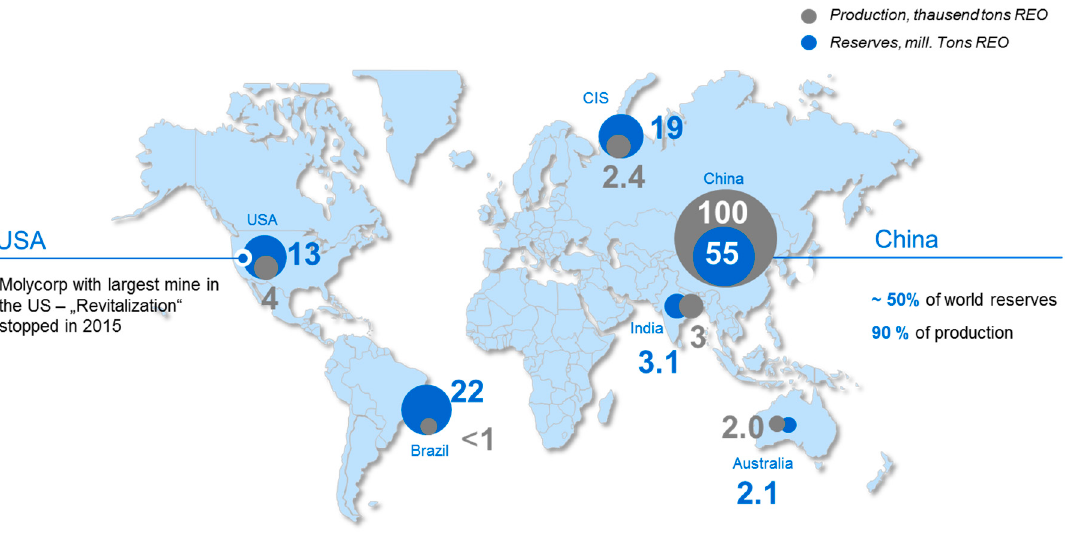
Figure 1. Overview of reserves and mining potential of REE [1].